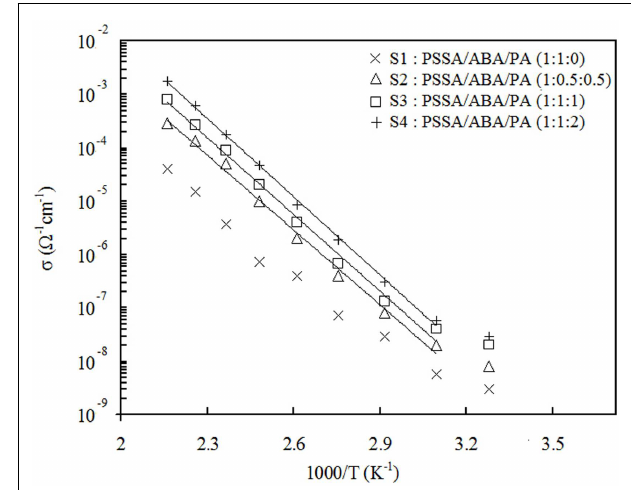
FIGURE 4 | Nyquist plot of S1: PSSA/ABA/PA (1:1:0) membrane under fully anhydrous conditions at 150°C . FIGURE 5 |Temperature dependence of conductivity in PSSA/ABA/PA composite membranes under fully anhydrous condition .